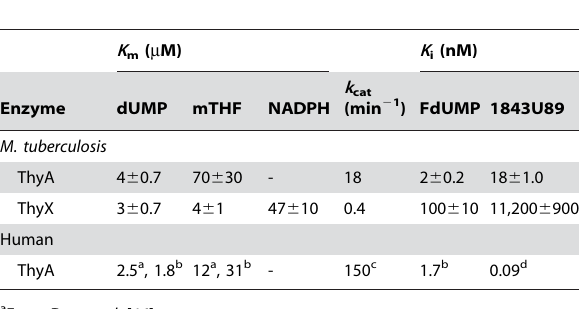
Table 2. Comparison of kinetics of Human ThyA to M. tuberculosis ThyA and